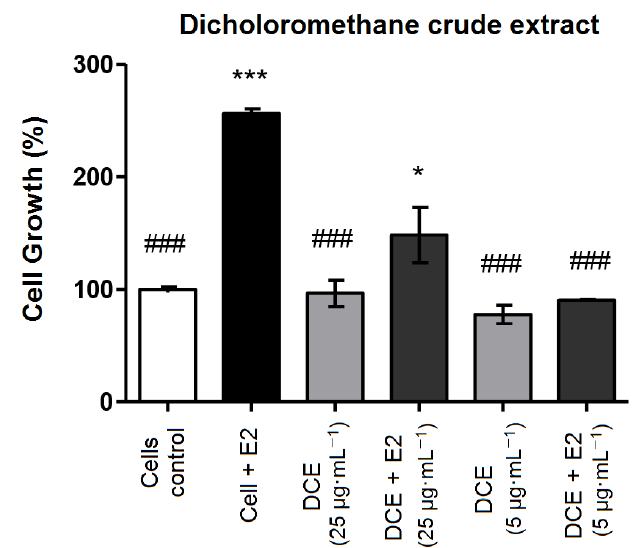
Figure 2. MCF-7 BUS cell proliferation, after DCE treatment in the presence and absence of 17 β -estradiol (E2, 10 − 9 M). MCF-7 BUS cells were treated with DCE at concentrations 5.0 and 25 μ g·mL − 1 for 144 h. *, # p < 0.05 and ***, ### p < 0.001 (analysis of variance (ANOVA)). * Statistical difference compared to control of cells without estradiol. # Statistical difference compared to control of cells with estradiol. Results expressed as mean ± standard deviation. Statistical analysis by One-way ANOVA followed by Tukey ’ s Test *, # p < 0.05 and ***, ### p < 0.001 (ANOVA). * Statistical difference in relation to control of cells without estradiol. # statistical difference compared to cells controlled with estradiol.